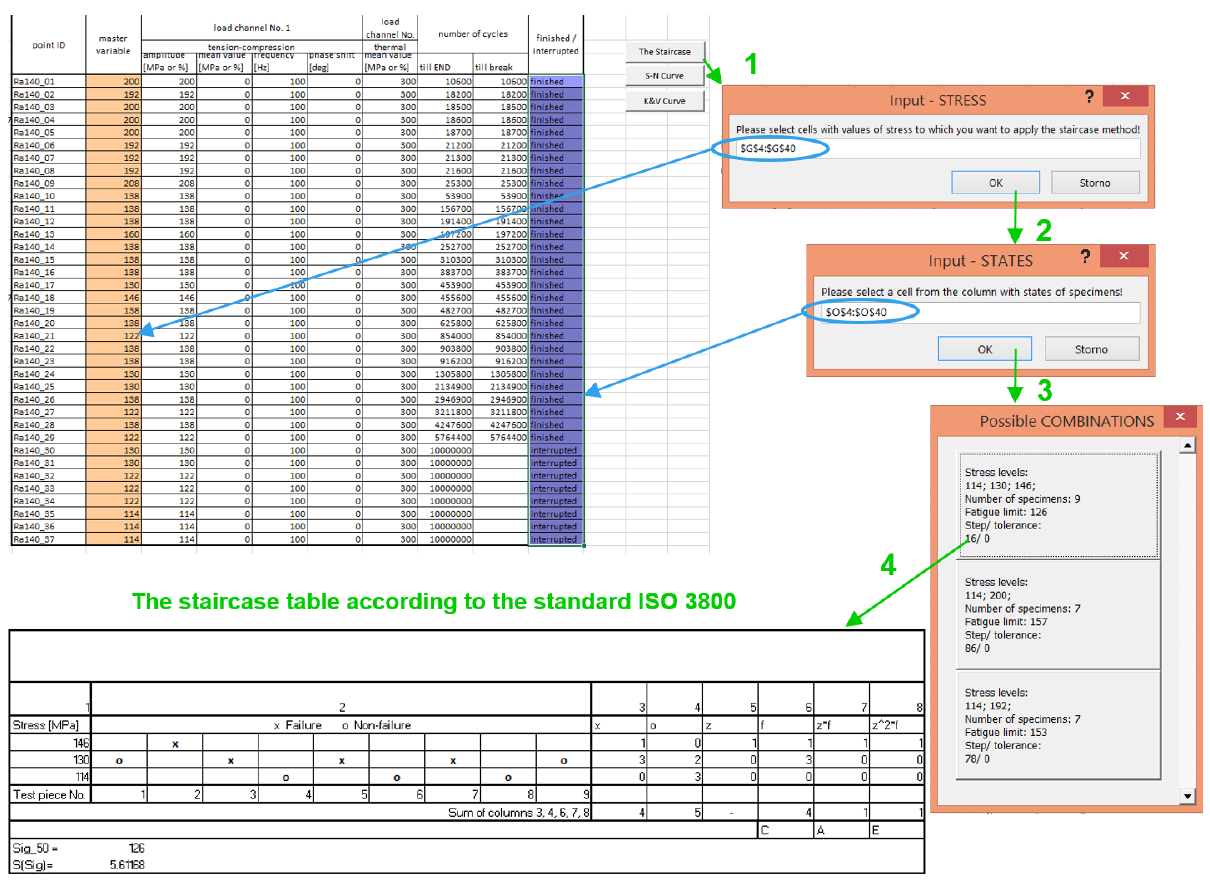
Figure 3. Process of generating the output table according to the staircase method in